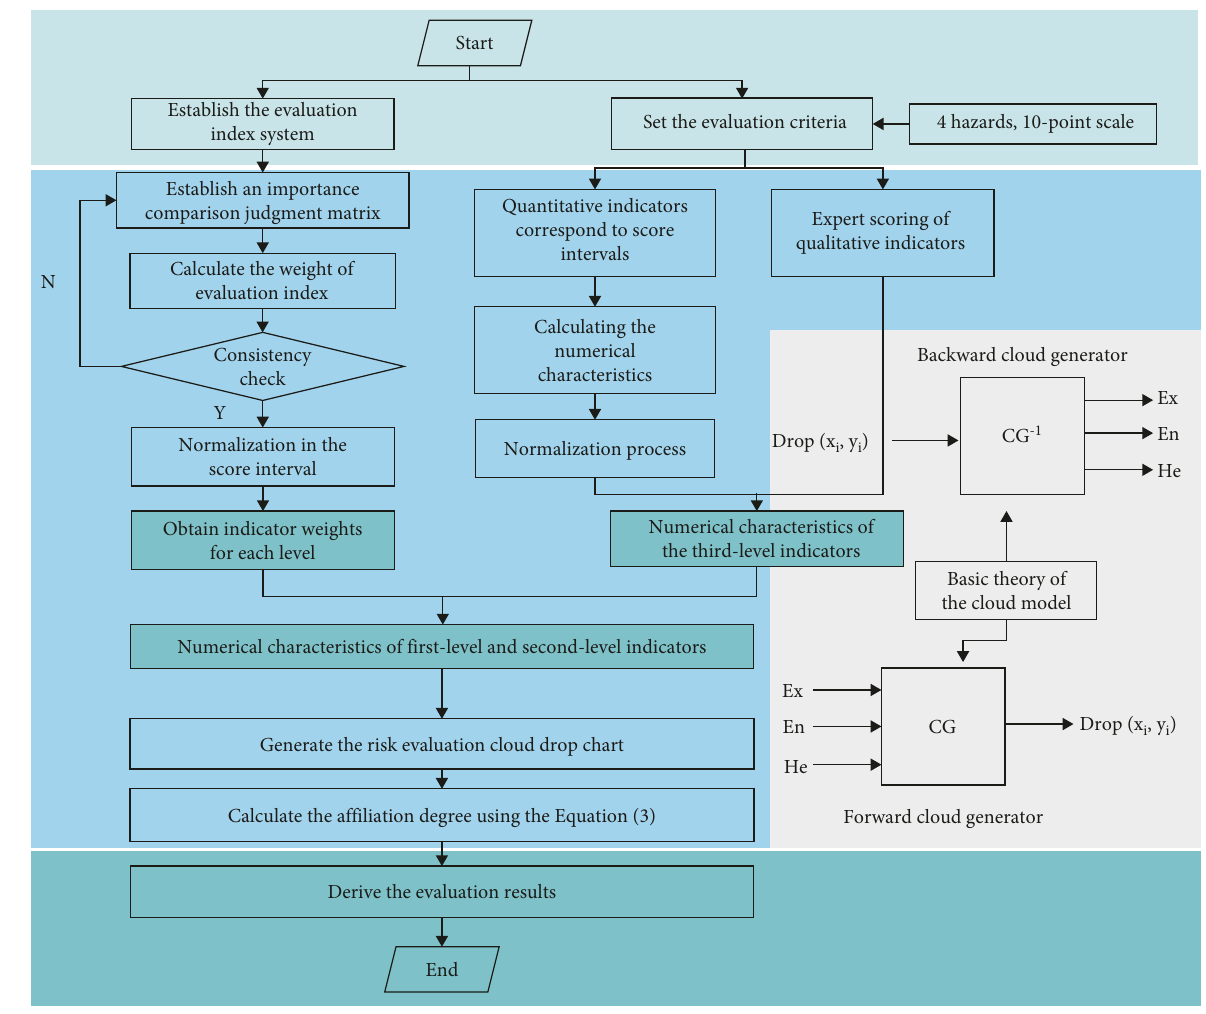
Figure 1: Flowchart of the evaluation model